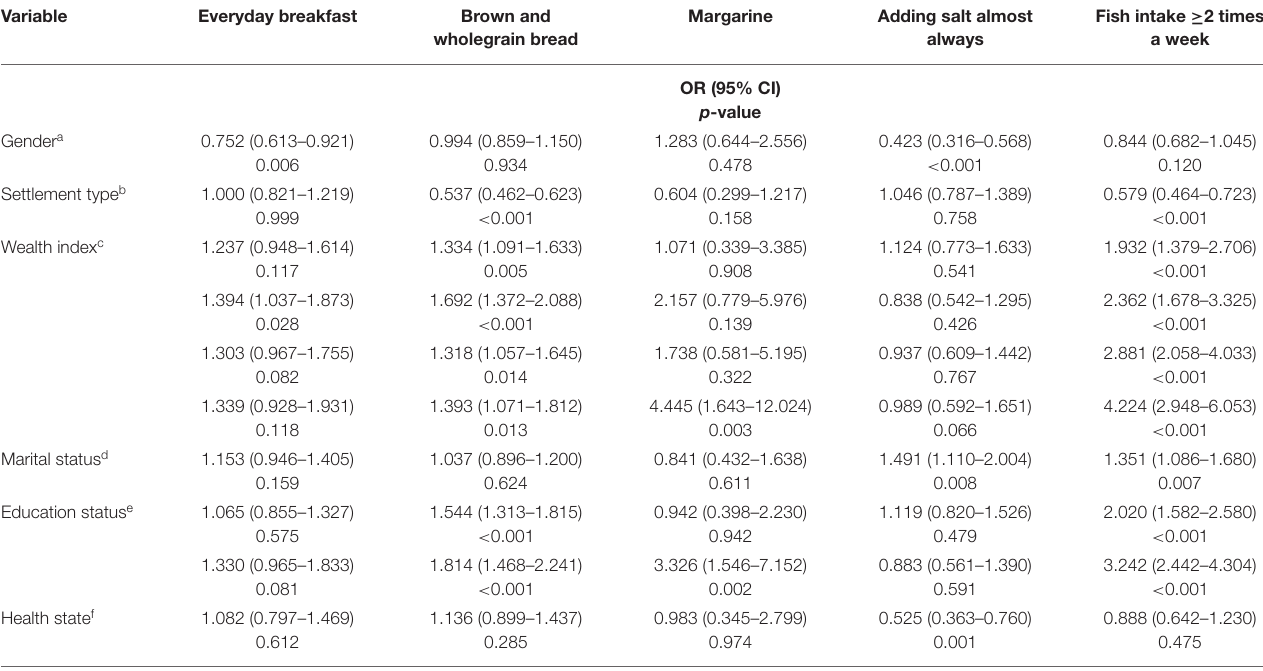
TABLE 4 | Factors associated with dietary habits of older adults in univariate binary logistic